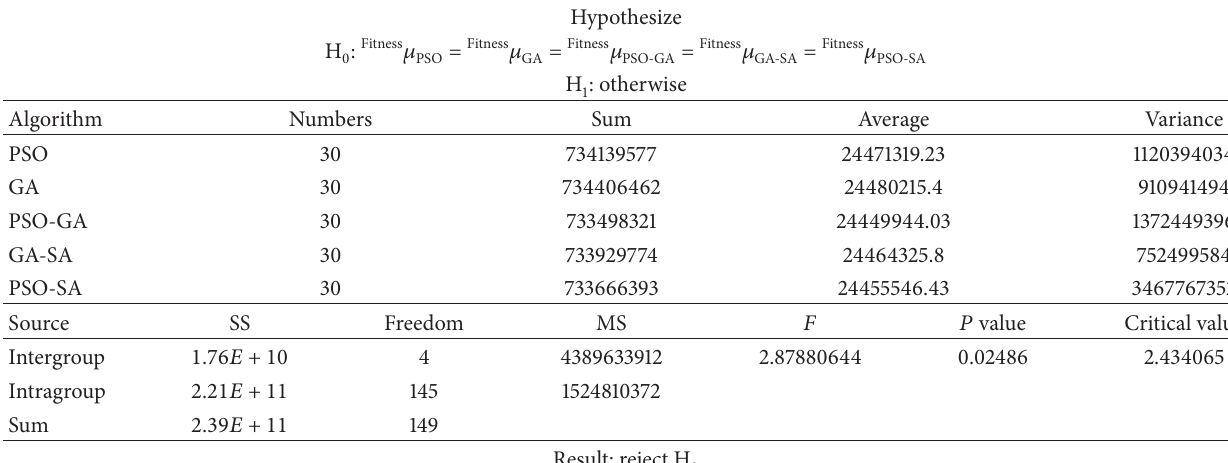
Table 2: ANOVA verification of fitness values.